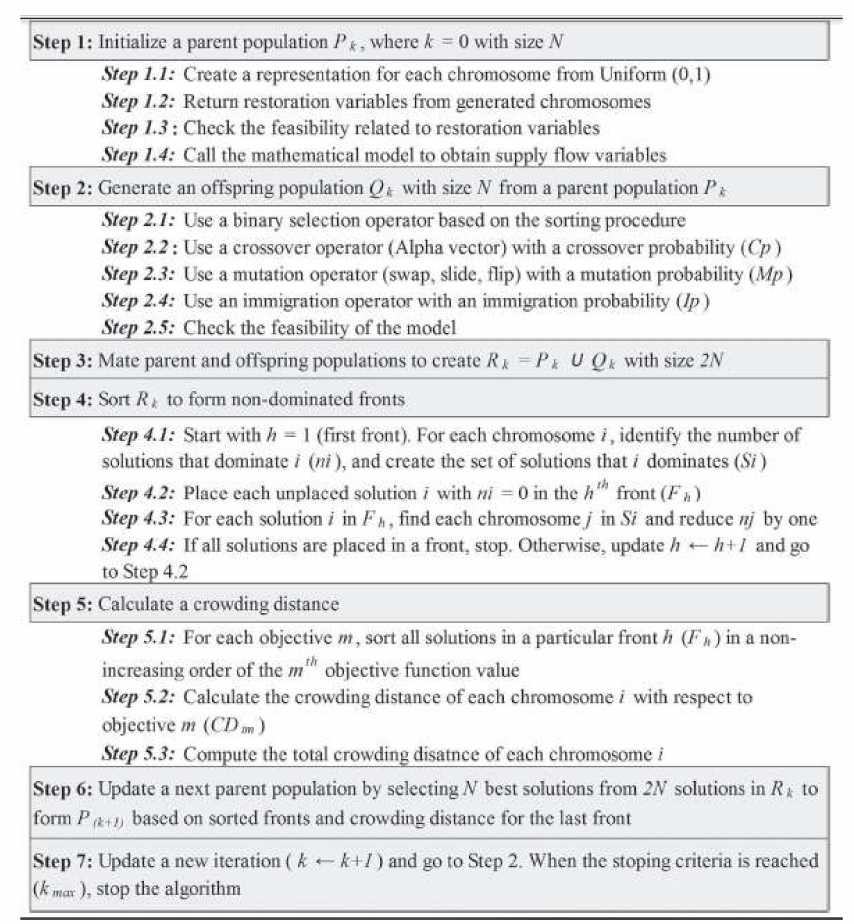
Figure 2. A schematic procedure of the NSGA-II